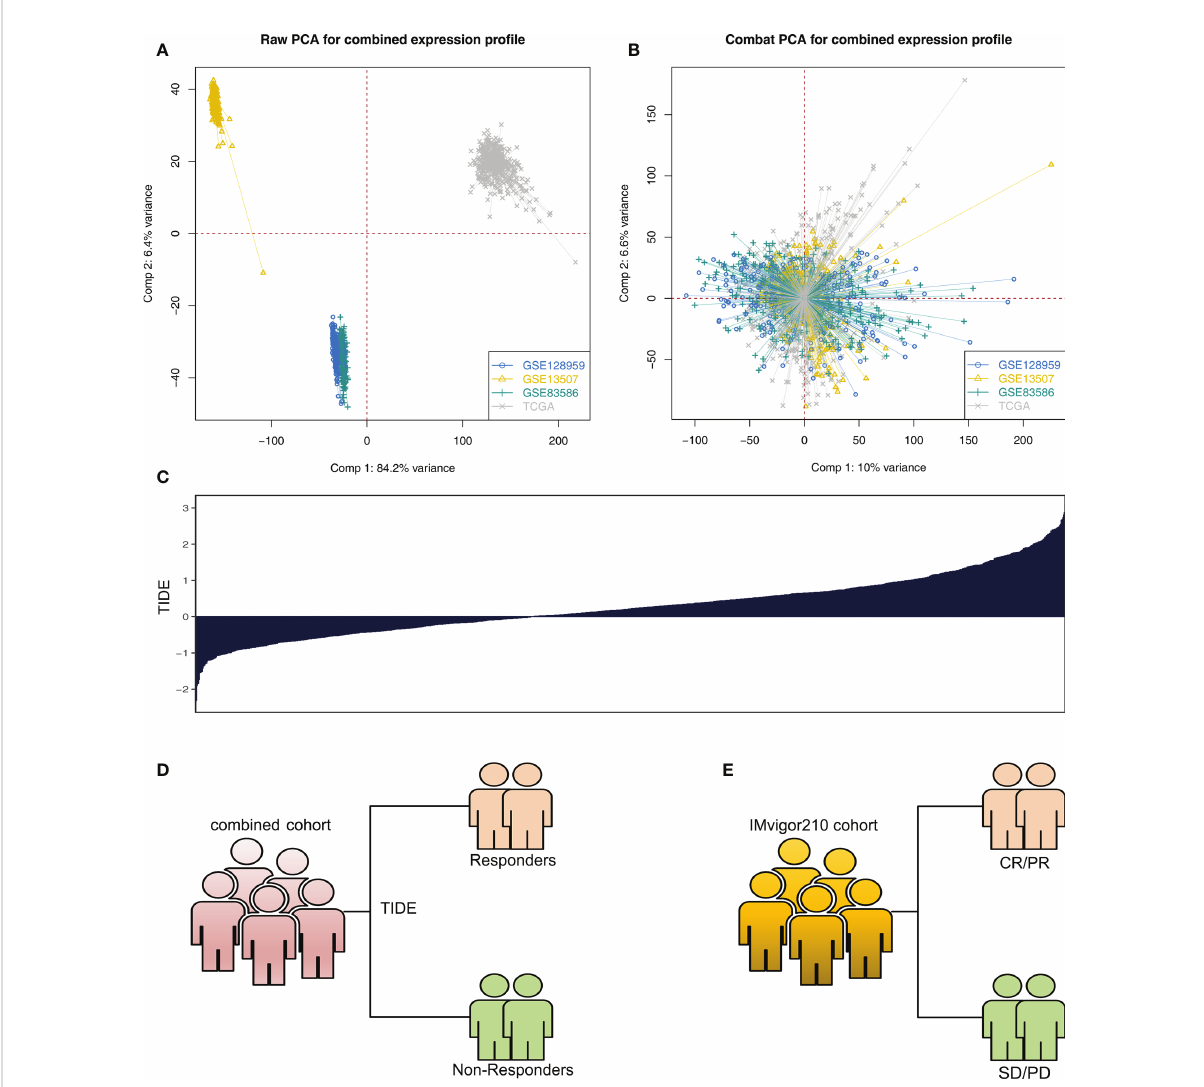
FIGURE 1 Data preparation (A) Signi fi cant batch effect of four independent bladder cancer cohorts was observed, namely, TCGA, GSE128959, GSE13507, and GSE83586. (B) Sva package was used for data combination and removal of batch difference. (C) Overview of TIDE score in the